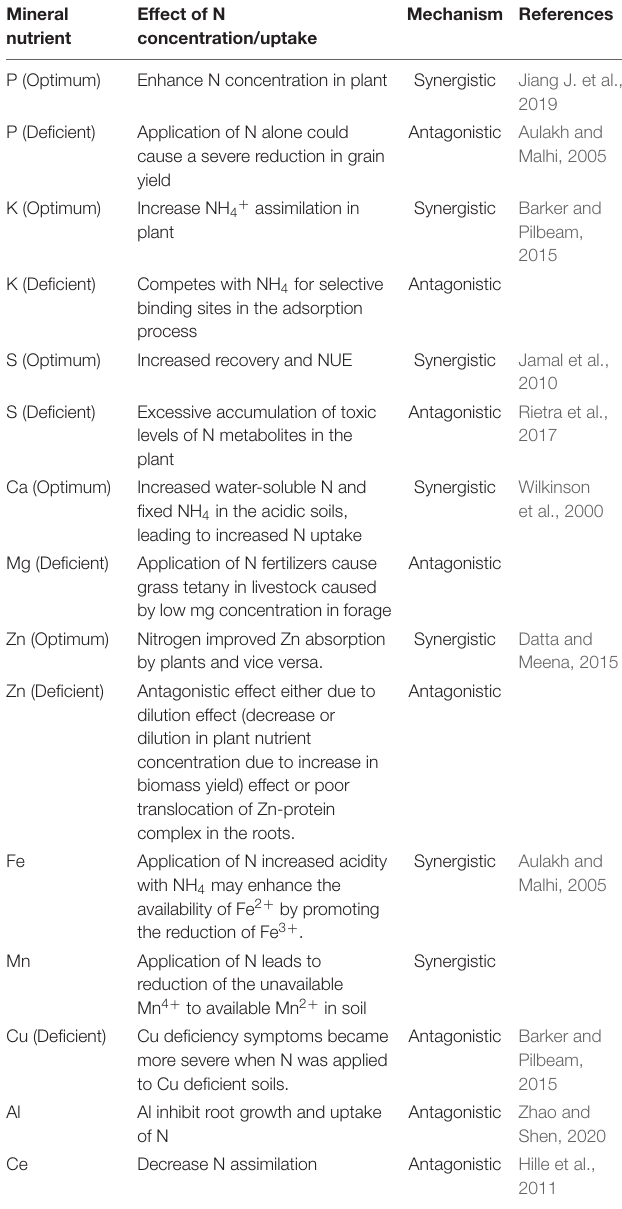
TABLE 1 | Cross talk of N with other essential